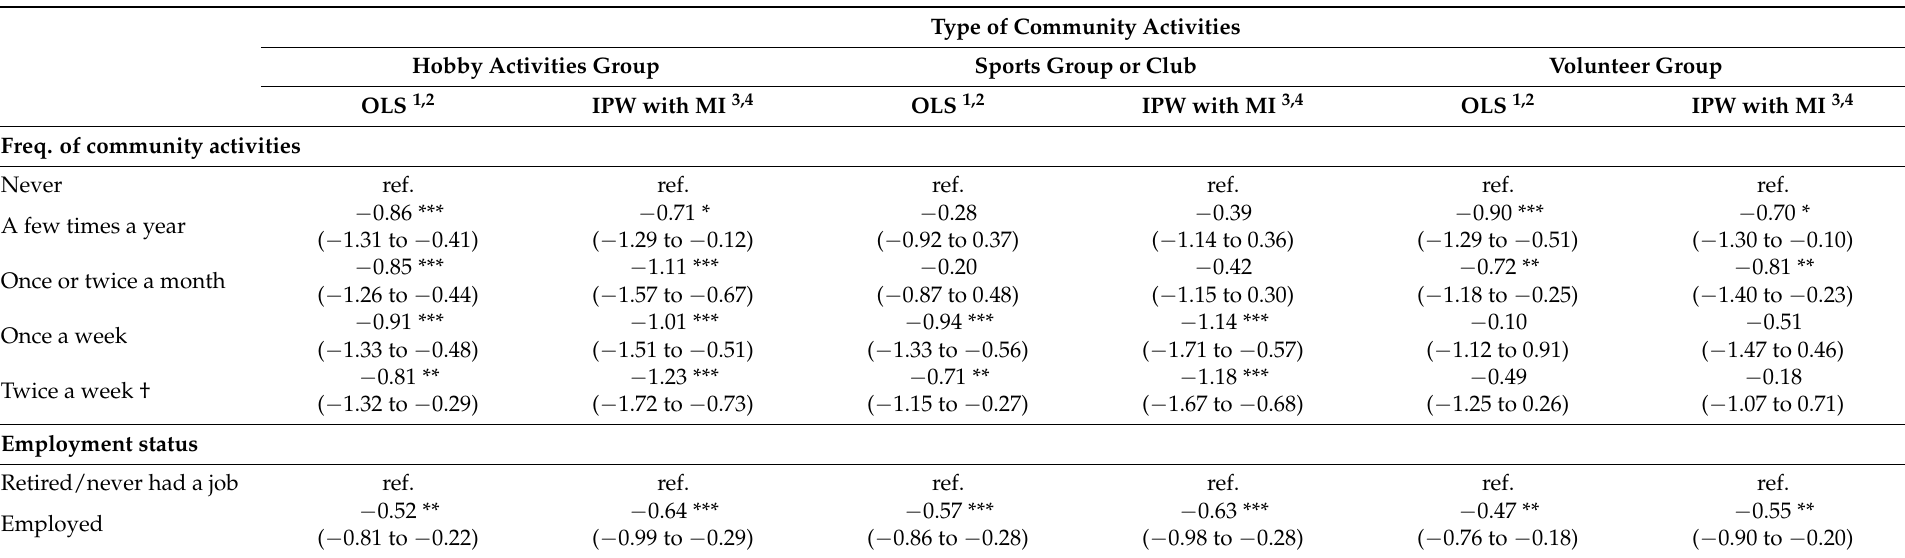
Table 2. Differences in cumulative LTC service costs over the 6-year follow-up period by community activities and employment